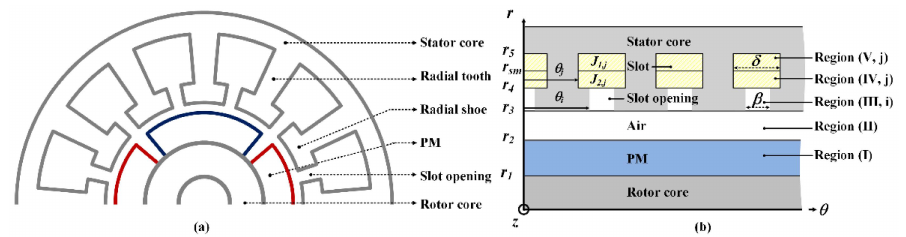
Figure 1. Structure of the PMSG: ( a ) analytical model; ( b ) simplified analytical model. Table 1. Specifications of the designed